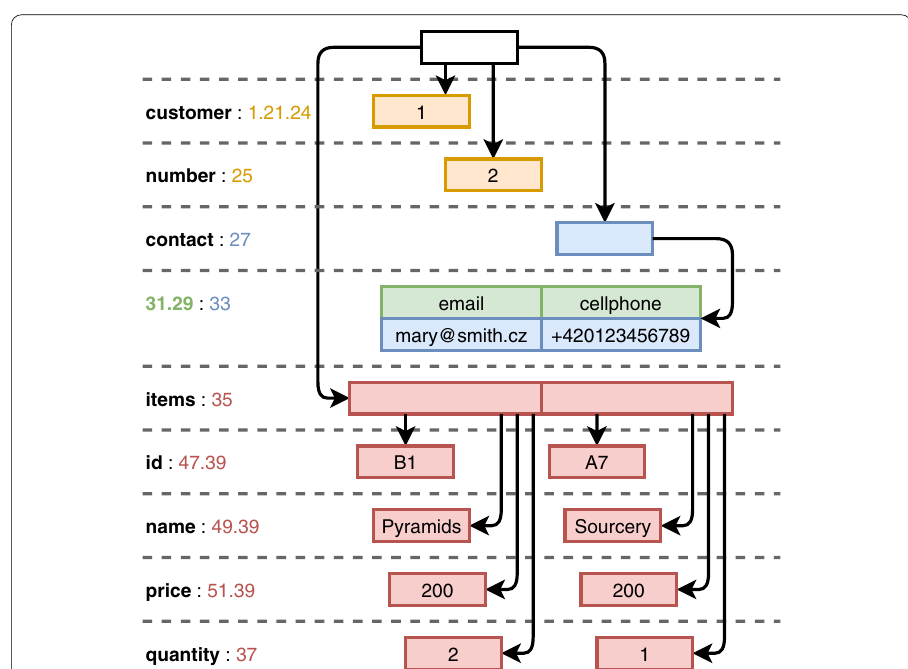
Fig. 7 Forest containing a single record corresponding to a